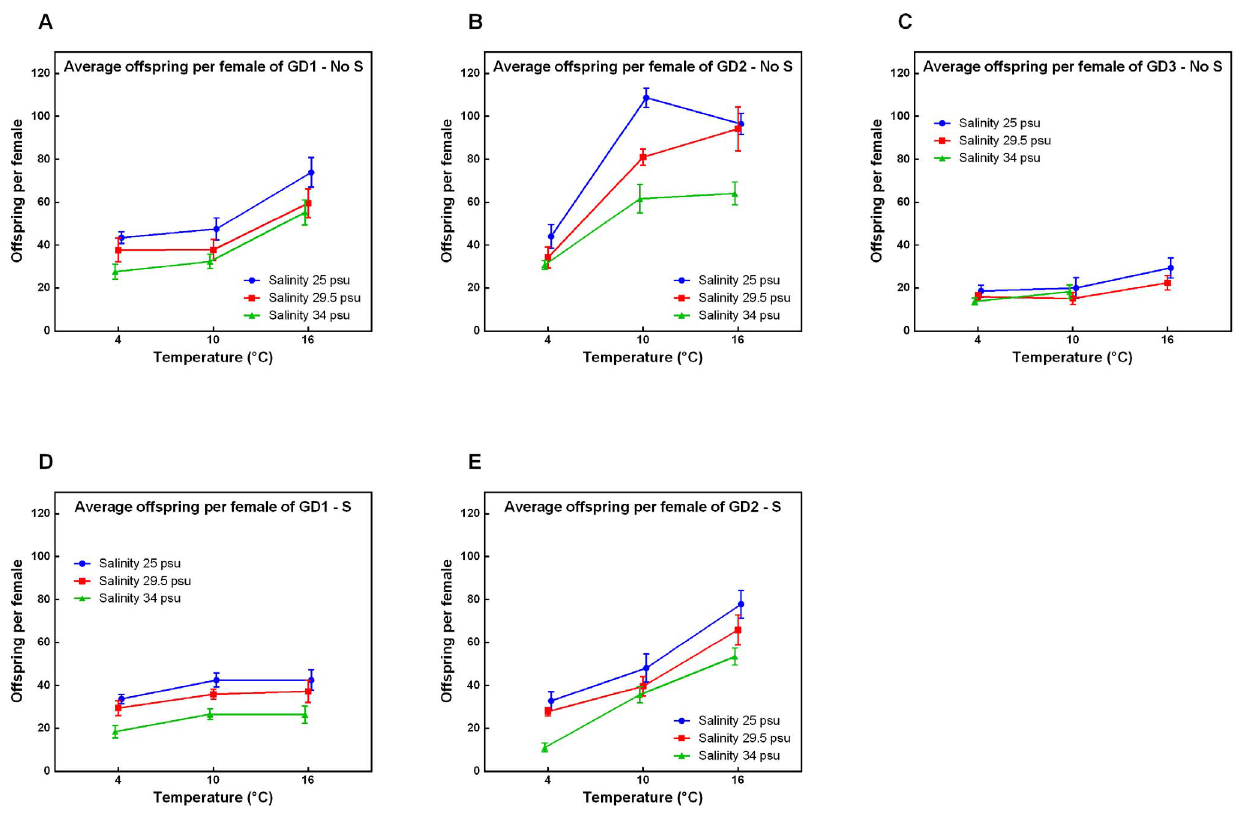
Figure 5. Offspring per female of GD1-3 under changing environmental conditions. Offspring per female in relation to temperature and salinity of cryptic Halomonhystera disjuncta species: GD1 (A, D), GD2 (B, E) and GD3 (C), in the absence (No S; A–C) and presence (S; D–E) of sulphide. The offspring corresponds to the amount of eggs, juveniles and new adults at the end of the experiment, averaged across six females. Data shown are mean values 6 1stdev of 3 or 4 replicates per treatment. No results were obtained for GD3 in the presence of sulphide because inoculated nematodes died within the first 1–2 minutes after adding sulphide.